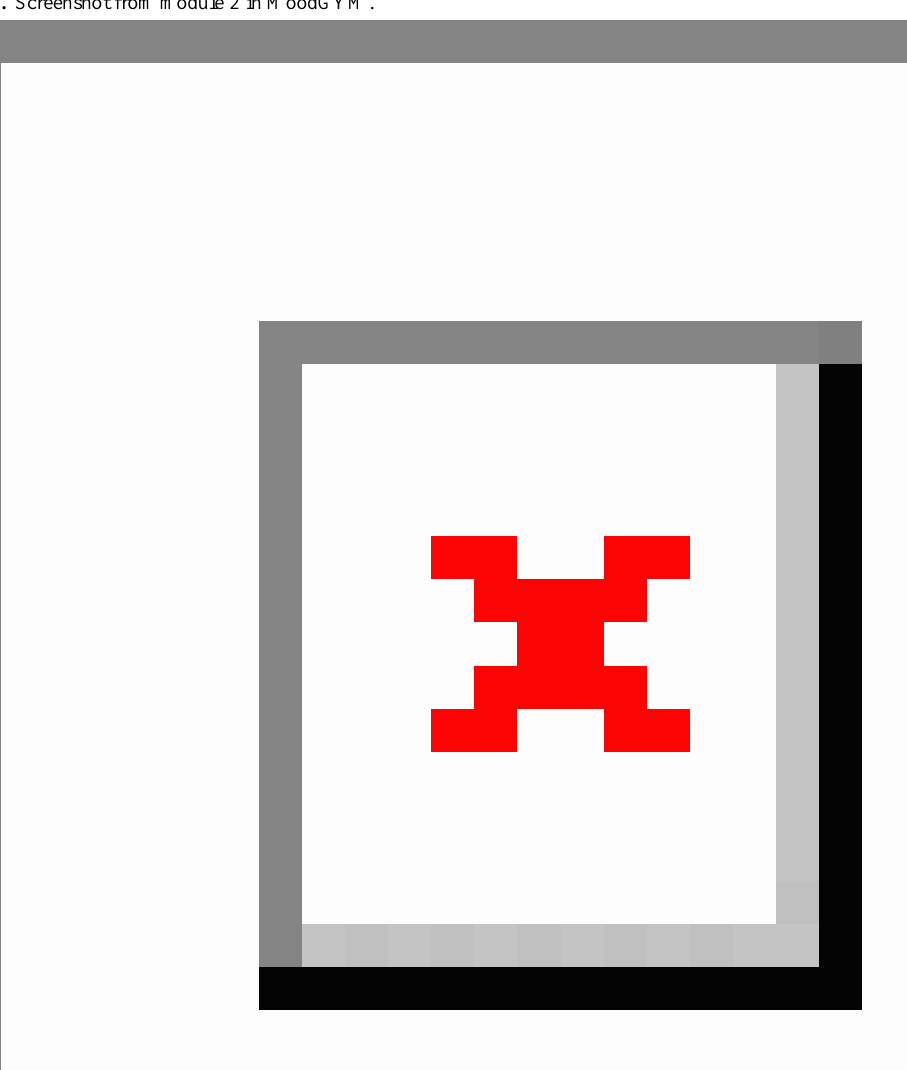
Figure 1. Screenshot from module 2 in